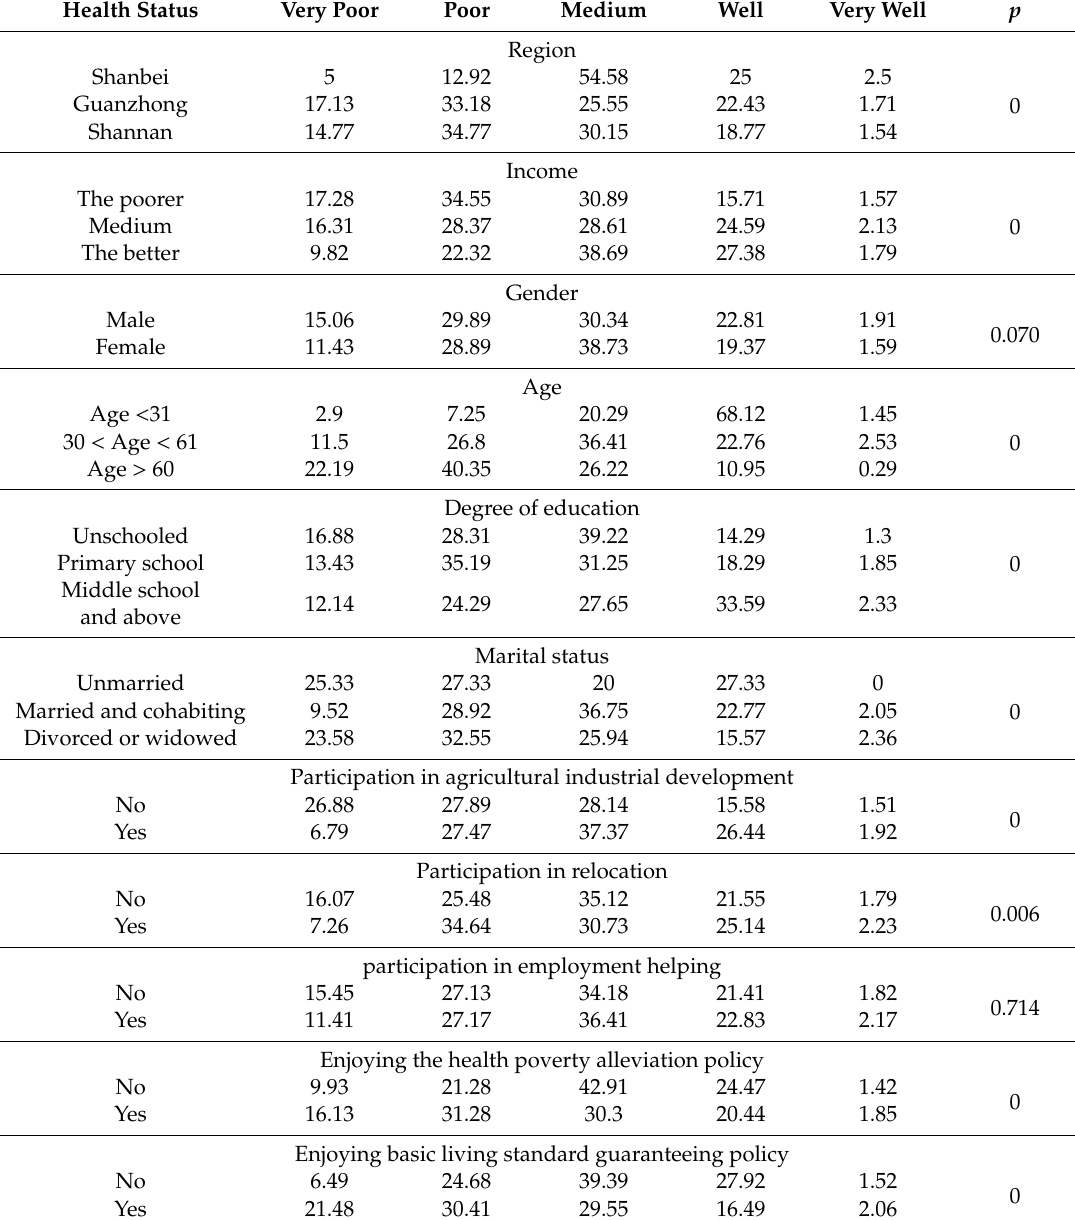
Table 3. Comparison of health status di ff erences among rural poor residents